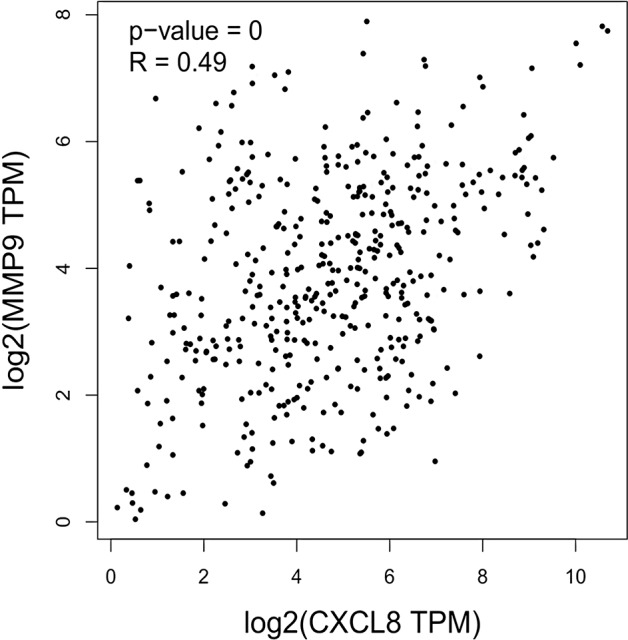
Correlation between CXCL8 and MMP9 expressions as indicated by transcripts per kilobase million (TPM) among human stomach adenocarcinoma (STAD) patients.